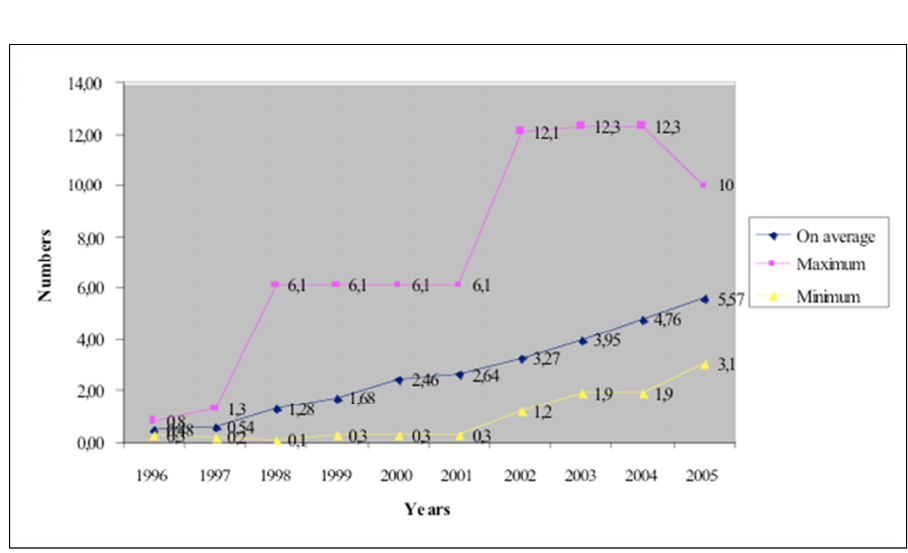
Figure 3 – Development of the amount of Megapixels per sq.in in hand-held digital cameras. Note the plateaus on both the minimum and maximum curves Secondly, there are the complementors. Even if saving photos in a digital format takes much less space than paper prints or slides, many families are used